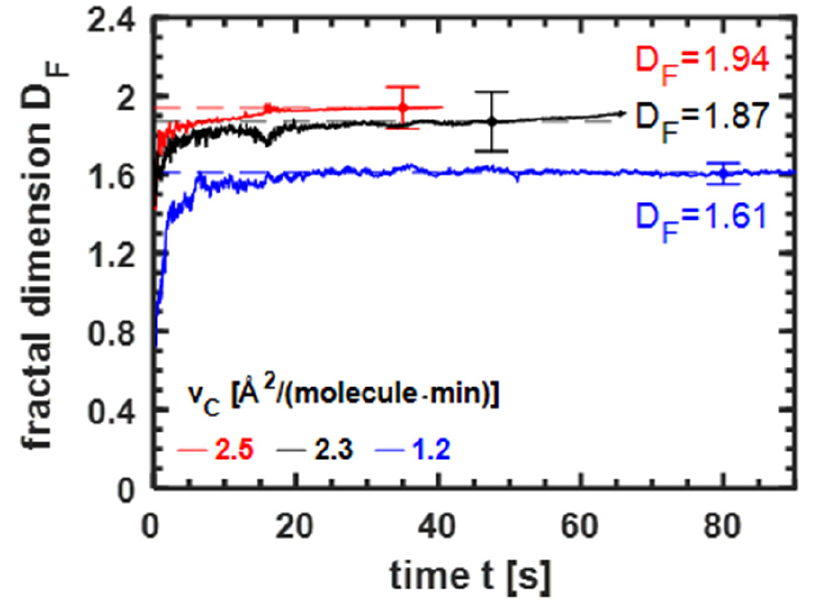
Figure 3. Fractal dimension D F of the domains in the coexistence region of erucic acid monolayers (experimental conditions as in Figure 1) at different compression velocities v C as a function of time t . The fractal dimension was determined as described in Appendix B. Exemplary error bars are in- cluded.